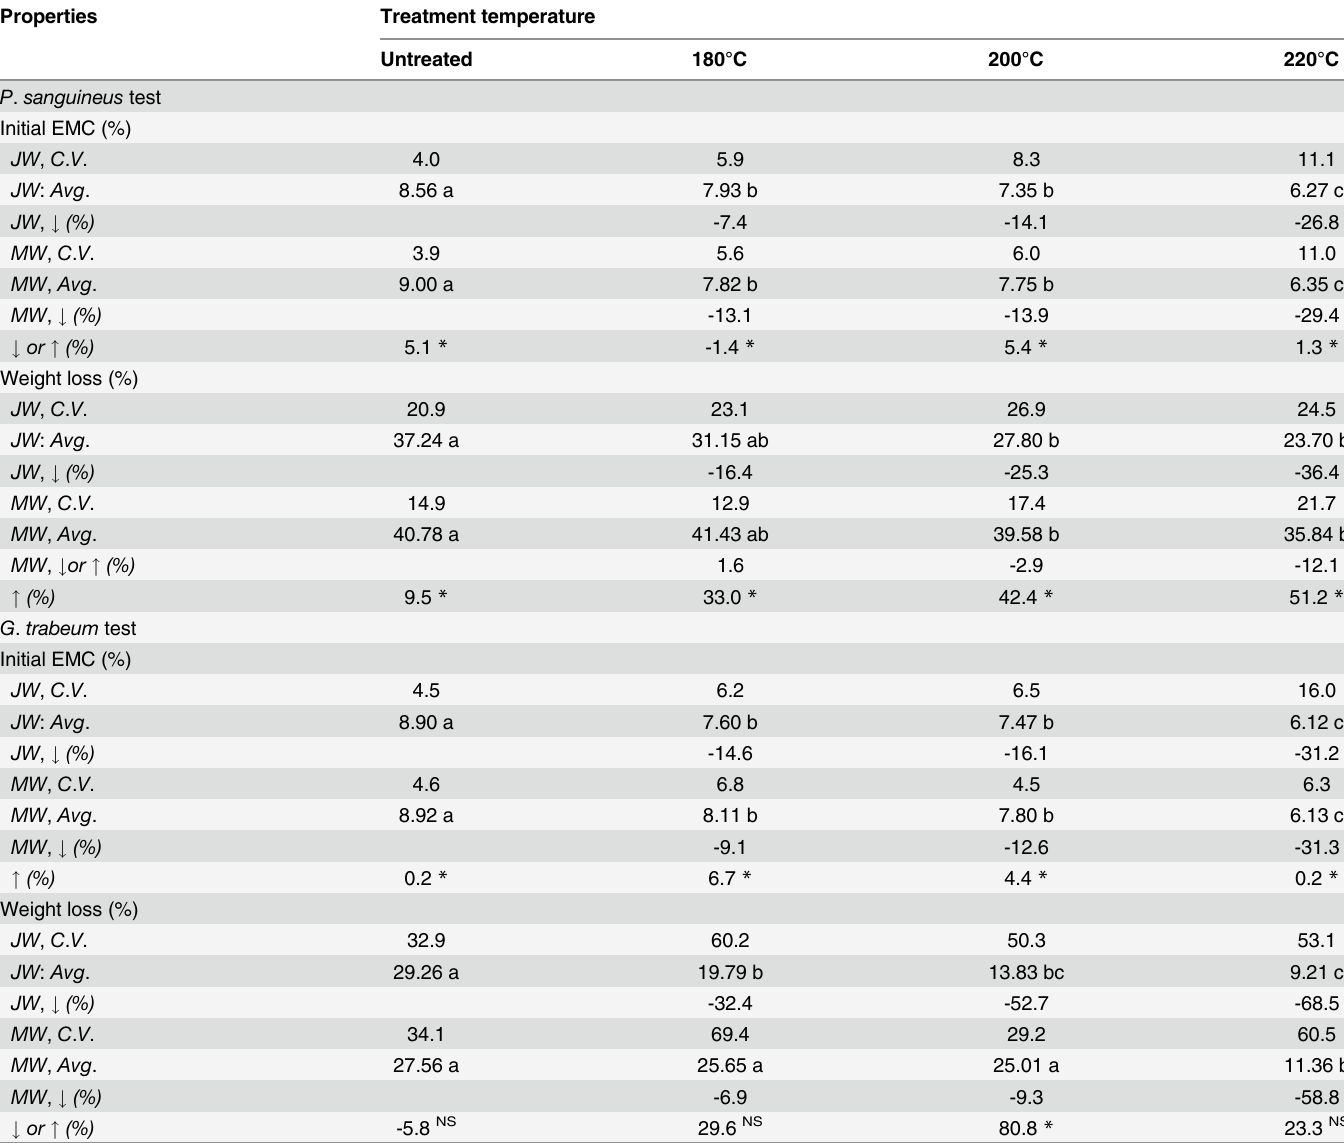
Table 2. Effect of thermal modification on the biological durability of juvenile and mature woods from Hevea brasiliensis at fungi Picnoporus san- guineous and Gloeophyllum trabeum . Properties Treatment